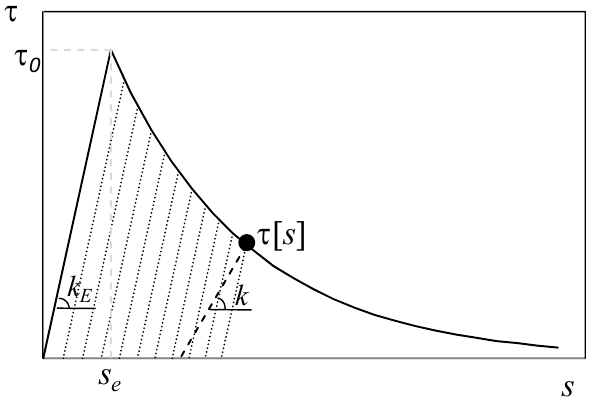
Figure 2. Bond-slip relationship and fracture work: exponential softening